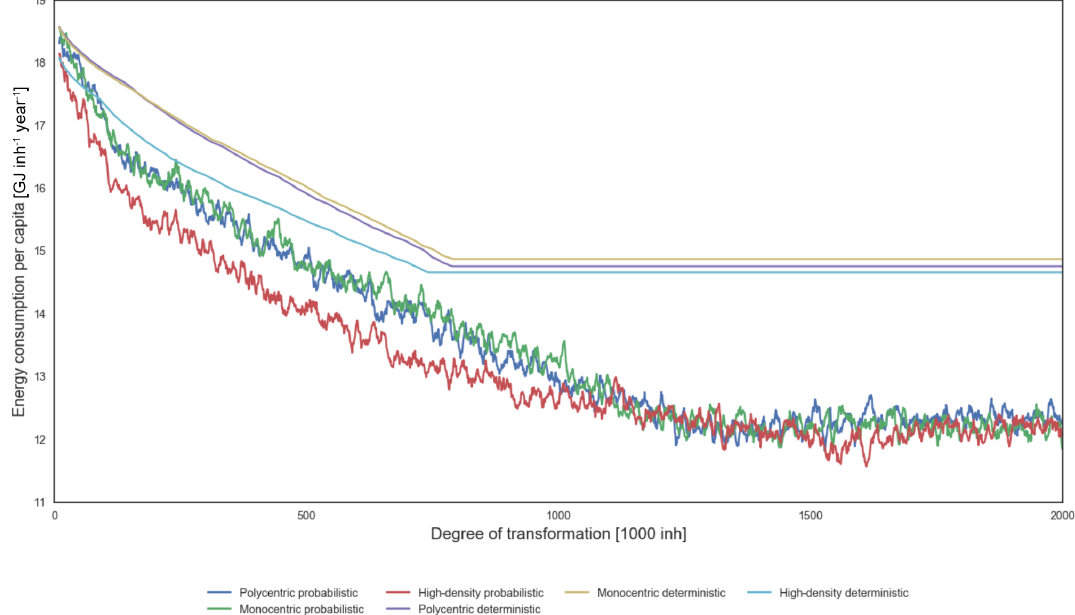
Figure 2. The energy consumption for urban mobility per capita is reduced along the transformation of the urban form. The deterministic approach does not account for uncertainty and its evolution appears more stable, although its insights are limited compared to those of the probabilistic approach, which helps in overcoming non-convexities in the feasible space of the optimization process, thus overcoming the limitations of a spatially explicit optimization in a changing urban